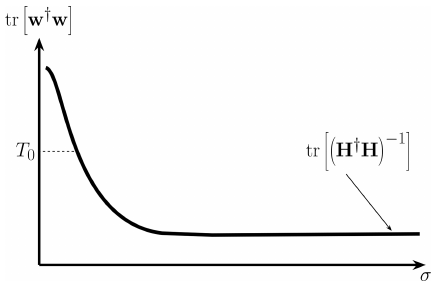
Figure 1. Sketch of the trace of the filter matrix with respect to (cid:113) + σ 2 n . For increasing values of the diagonal loading pa- σ = σ 2 d rameter σ d the output signal–noise ratio increases and Capon’s filter converges to the least square fit filter if the diagonal loading param- eter is